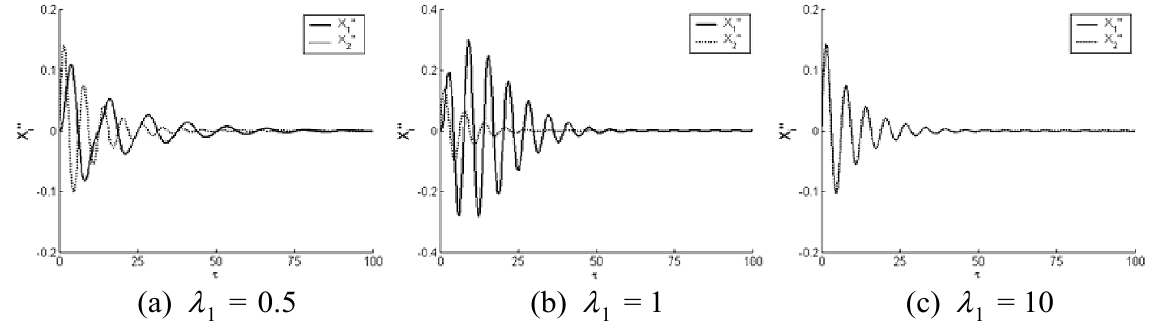
Fig. 2. Acceleration-time response history of critical component and main body at different frequency parameter ratios. Here, βu τ 0 = 0 . 5 , λ 2 = 0 . 01 , ζ 1 = 0 . 1 , ζ 2 = 0 . 1 .